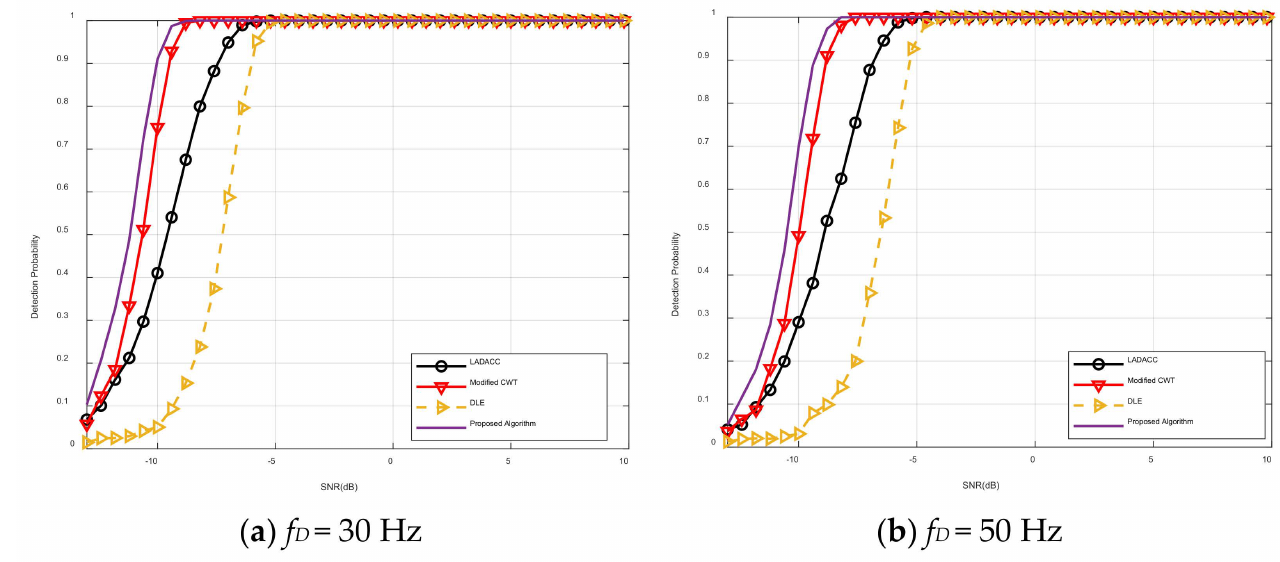
Figure 15. Detection performance under the Rayleigh